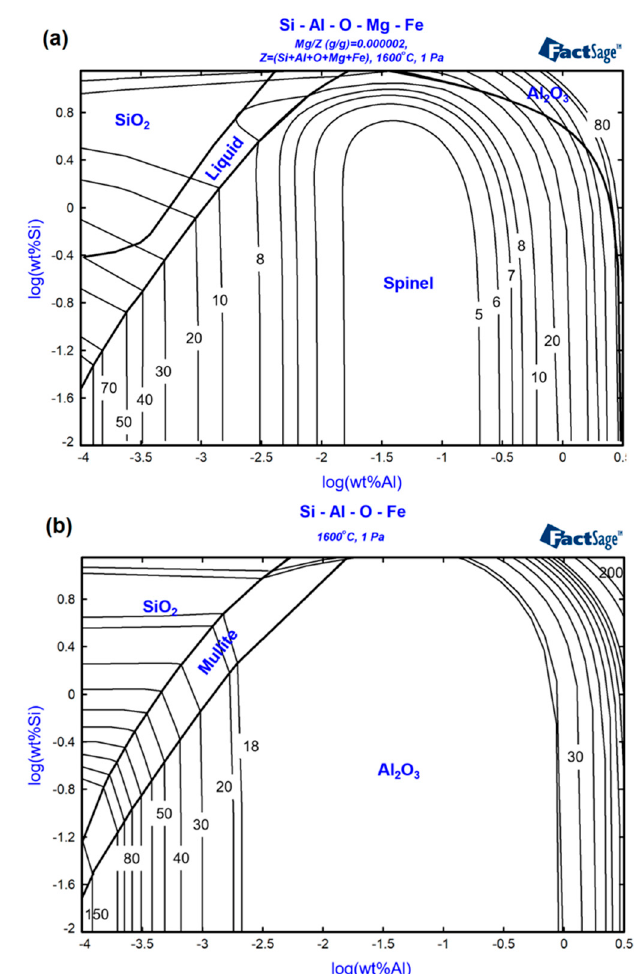
Figure 3. Calculated inclusion stability diagrams of the Fe-Si-Mg-O system ( a ) and the Fe-Si-O system ( b ) at 1600 °C.